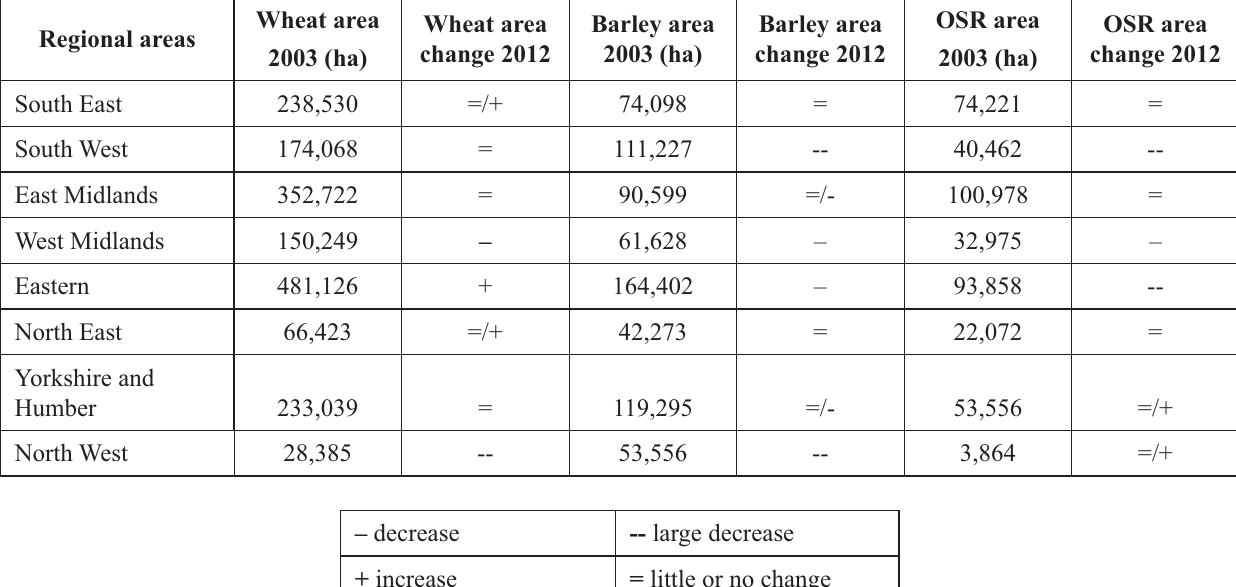
Table 5. Impact of the CAP on land allocated to cereals and oilseed rape by region in England Regional